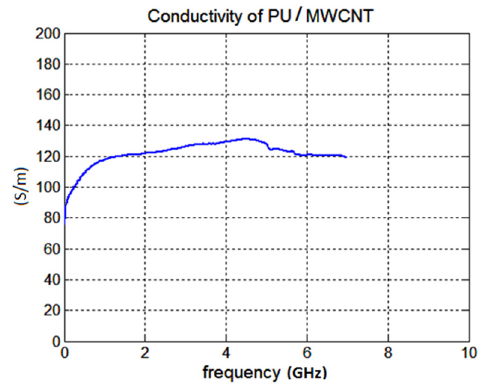
Figure 10. Measured results of the effective conductivity of the PU/MWCNT composite by a microstrip line.